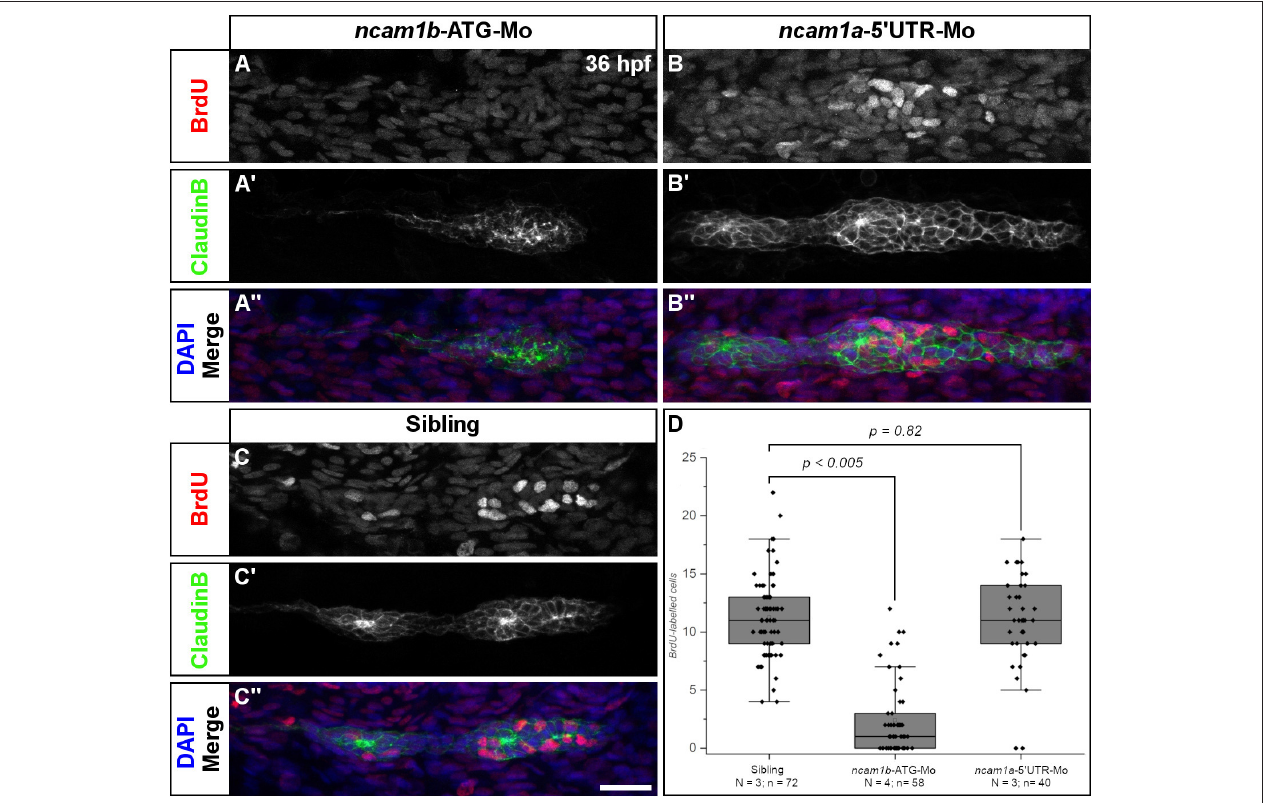
FIGURE 2 | Ncam1b is required for cell proliferation within the primordium. Siblings or morpholino-injected Tg(ClaudinB::lynGFP) embryos were treated with BrdU at 36 hpf for 20min, fixed and immunostained for BrdU (red), GFP (green) and DAPI (blue) as indicated. (A,A ′′ ) BrdU incorporation is almost absent in ncam1b -morphants, but obvious in (B,B ′′ ) knockdowns of ncam1a and (C,C ′′ ) uninjected siblings. (D) Quantification of BrdU-labeled cells within primordia. Scale bar 20 µ m.